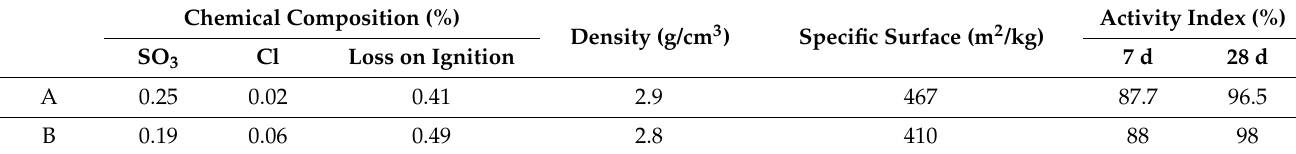
Table 3. Chemical Composition and Physical Properties of GGBS.